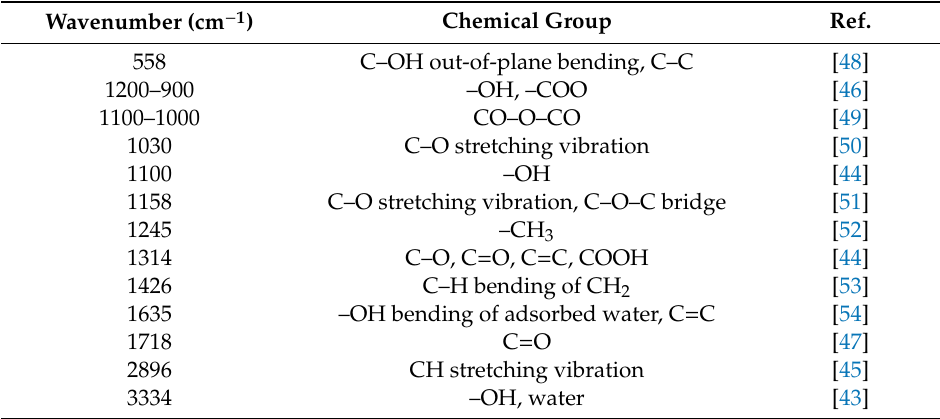
Figure 2. Fourier transform infrared spectroscopy (FT-IR) spectra of cellulose fibers modified via a regular approach (MA treatment) and unmodified. Characteristic absorption bands: 3334 cm − 1 (O–H, water), 2894 cm − 1 (C–H), 1718 cm − 1 (C = O), 1200–900 cm − 1 (O–H, C–O, –COO, CO–O–CO), and 558 cm − 1 (C–OH, C–C). Table 3. Tabularized absorption bands assigned to the chemical